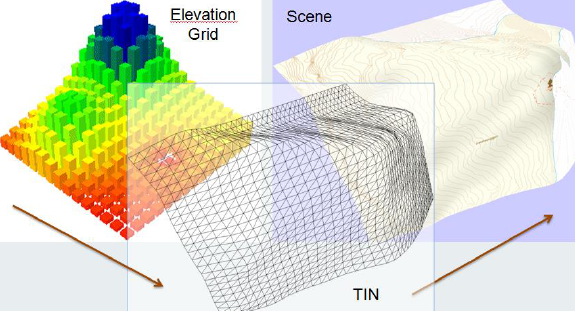
Figure 11: Combination of a TIN and a Map image makes an interactive "Scene".